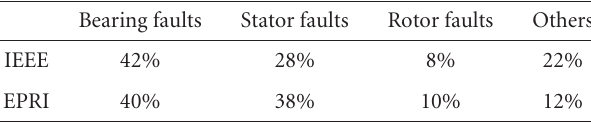
Table 1: Fault occurrence possibility on induction motor